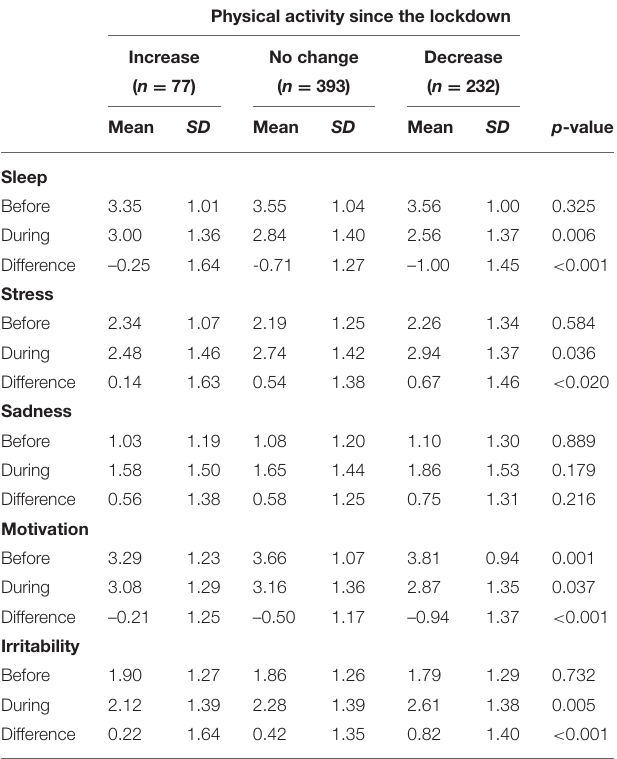
TABLE 5 | Impact of the lockdown on psychological distress values correlating with physical activity. Physical activity since the lockdown